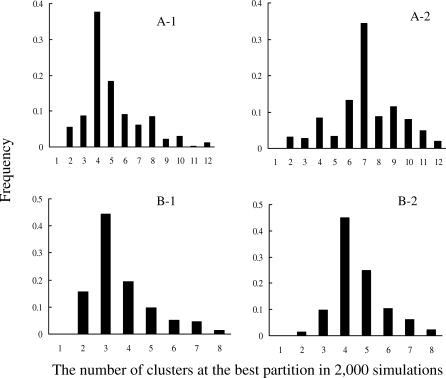
Examples of Distributions of Clusters at the Best Partition (T[best]) in 2,000 Simulations with the Two Clustering Methods under Different SettingsA-1 and A-2 present the distributions of clusters at T[best] using our weighted cladistic analysis method and CLADHC, respectively, when original haplotypes have a high diversity (the number of distinct haplotypes is 12); B-1 and B-2 display the distributions of clusters at T[best] corresponding to using our proposed method and CLADHC when original haplotypes have a low diversity (the number of distinct haplotypes is eight). Other parameters considered in the simulations are the same for A-1, A-2, B-1, and B-2, which include: q = 0.1, r = 1.75, and assuming an additive model.